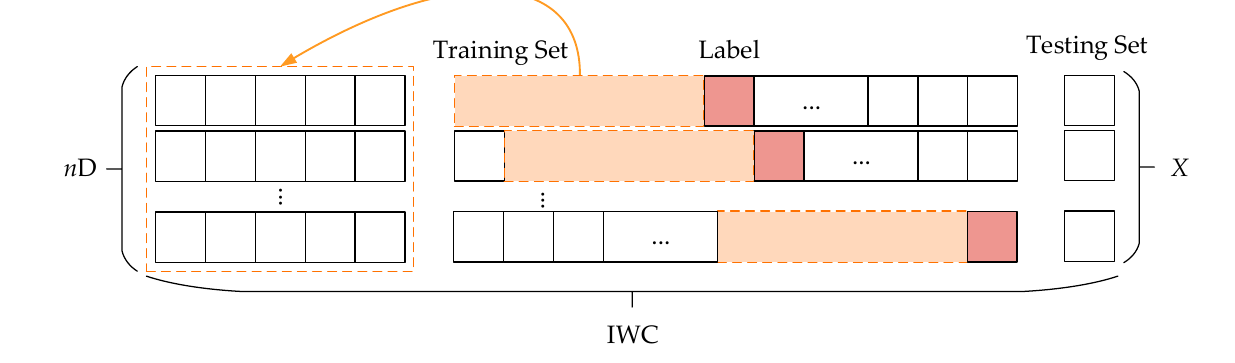
Figure 3. Schematic diagram of IWC configuration.